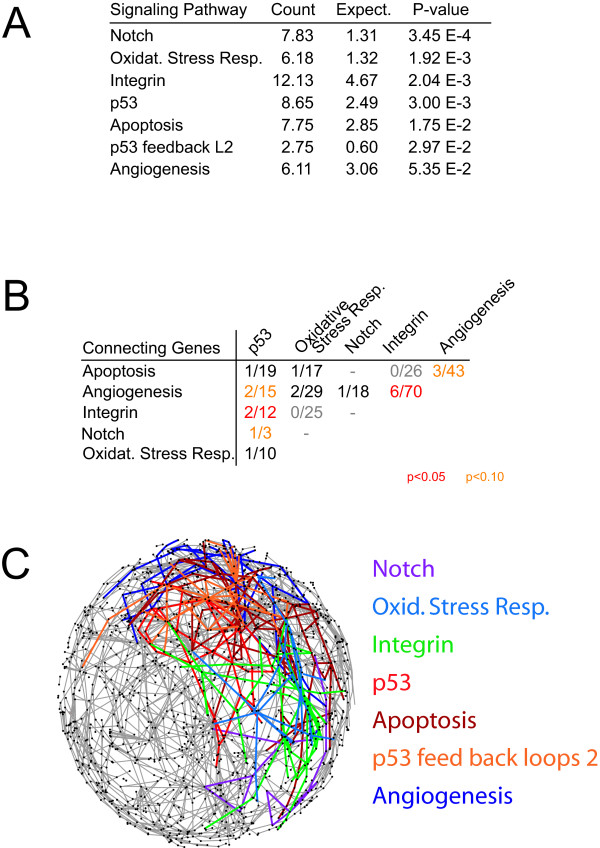
Pathway analysis of the TAF6δ transcriptome signature. (A) Specific cellular pathways are statistically significantly (P < 0.05) overrepresented in the TAF6δ-regulated transcriptome. "Count" indicates the number of probes within the dataset that corresponds to a given gene ontology pathway, "Expect." is the number of probes one would expect to find for a given pathway in a random dataset of identical size. (B) Interconnectivity analysis reveals statistically significant overrepresentation of shared genes between TAF6δ-affected cellular pathways. Red and orange indicate highly significant (P < 0.05) and significant (P < 0.10) overrepresentation of shared regulated genes, light grey indicates present links of low statistical significance between the pathways from B. (C) Interconnectivity between overrepresented pathways (highlighted in color and listed at right) is shown in a network representation generated using Pajek software [27].